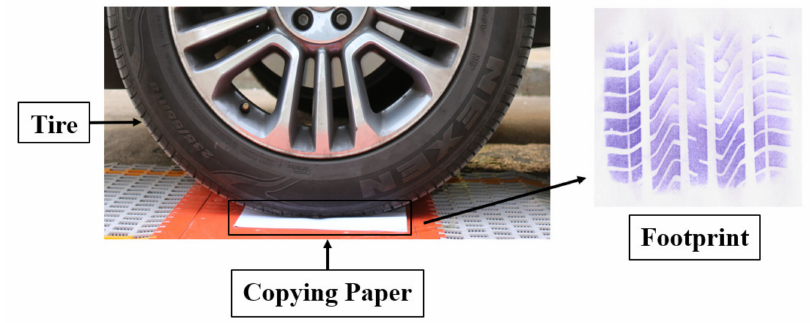
Figure 8. Test for obtaining the tire footprint.